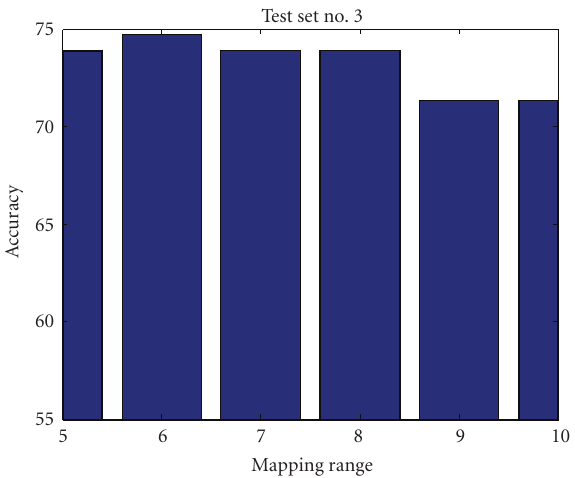
Figure 11: Mapping range impact on accuracy for test set number 3.